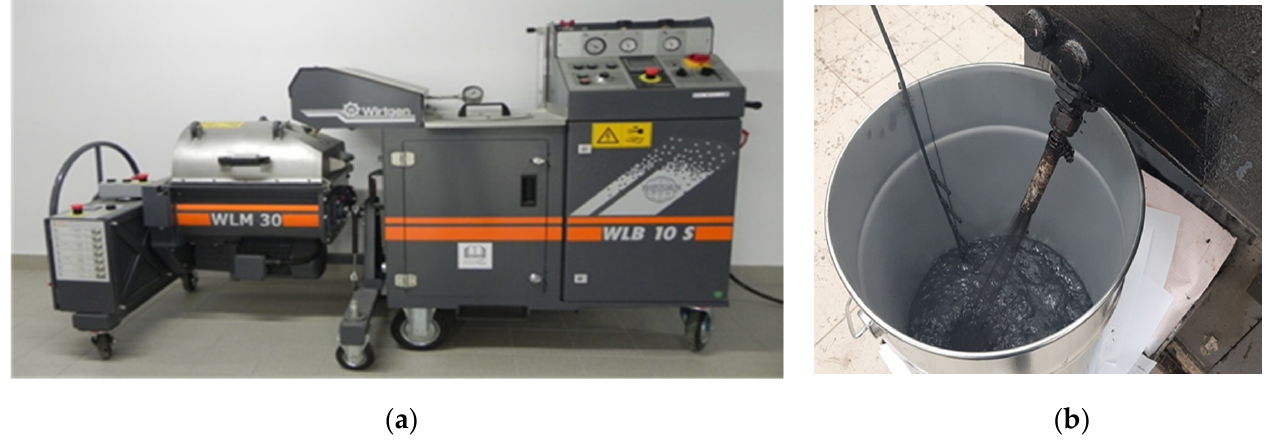
Figure 19. WLB-10 foamed bitumen plant ( a ) and a adapter for determining foamed bitumen characteristics ( b ).